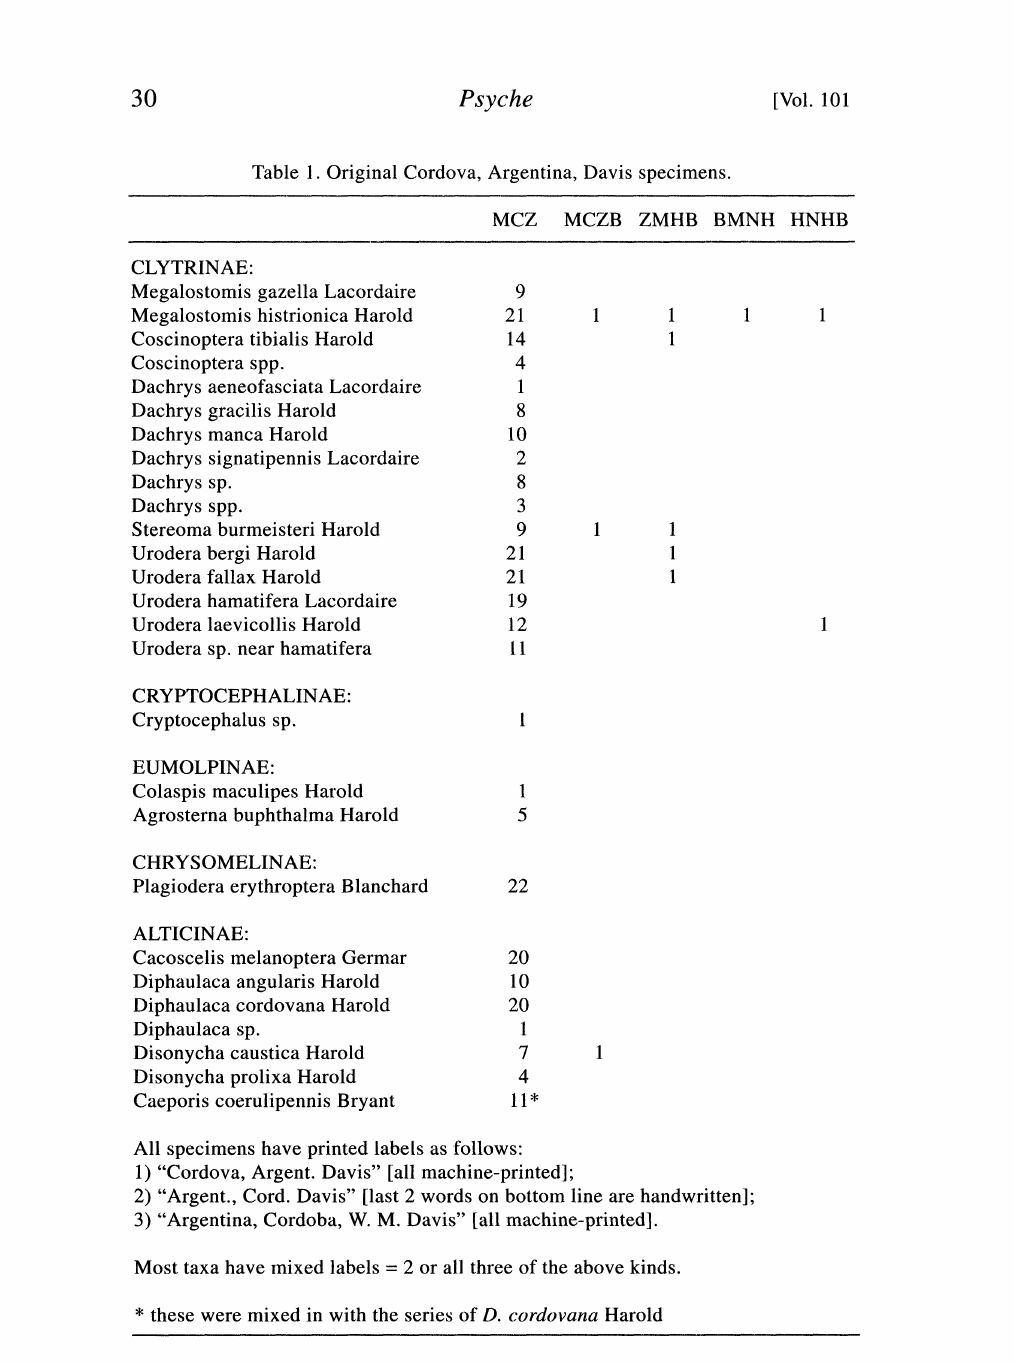
Table 1. Original Cordova, Argentina, Davis